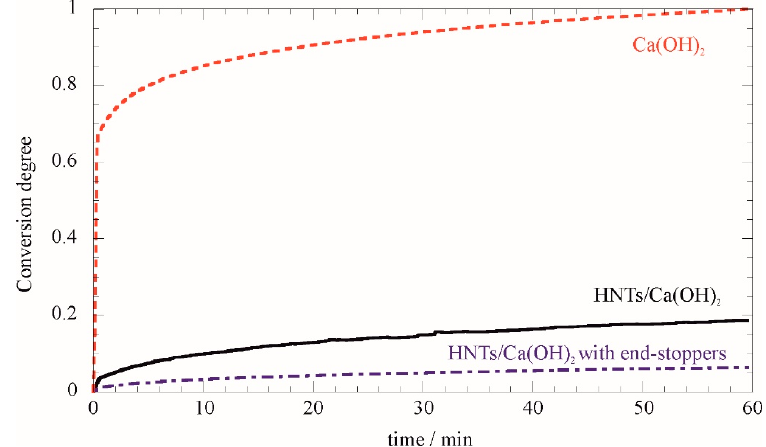
Figure 6. Degree of Ca(OH) 2 carbonation in a CO 2 atmosphere for Ca(OH) 2 , HNT/Ca(OH) 2 and HNT/Ca(OH) 2 with phosphate end-stoppers.